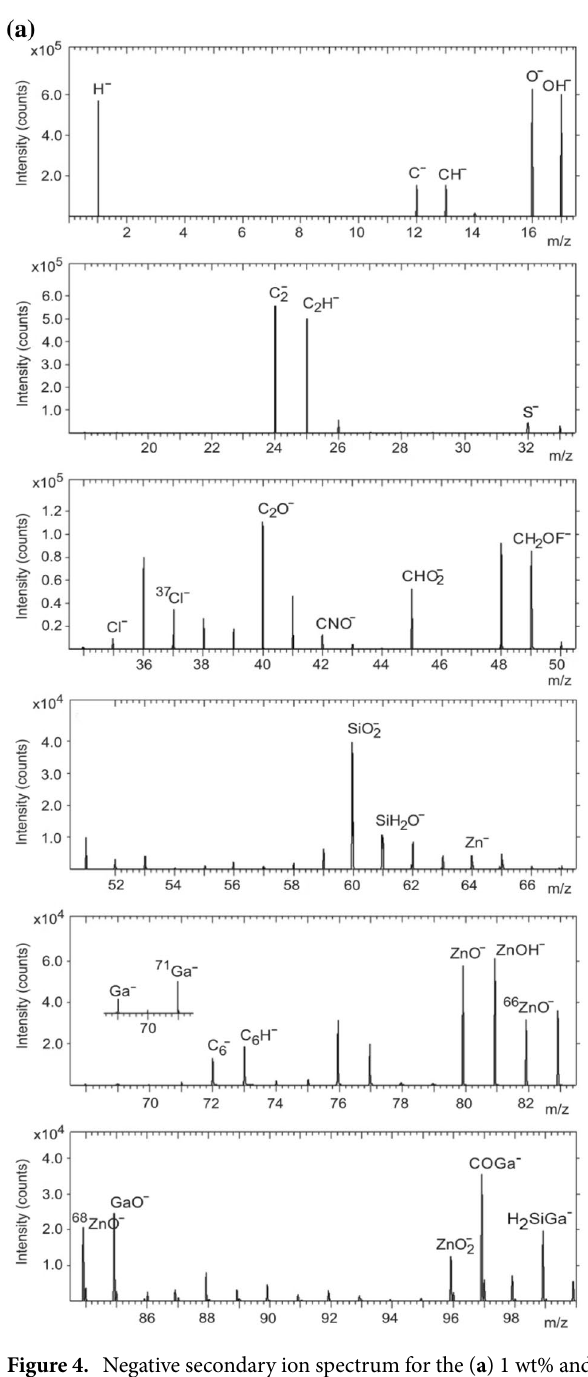
Figure 4. Negative secondary ion spectrum for the ( a ) 1 wt% and ( b ) 7 wt% GZO